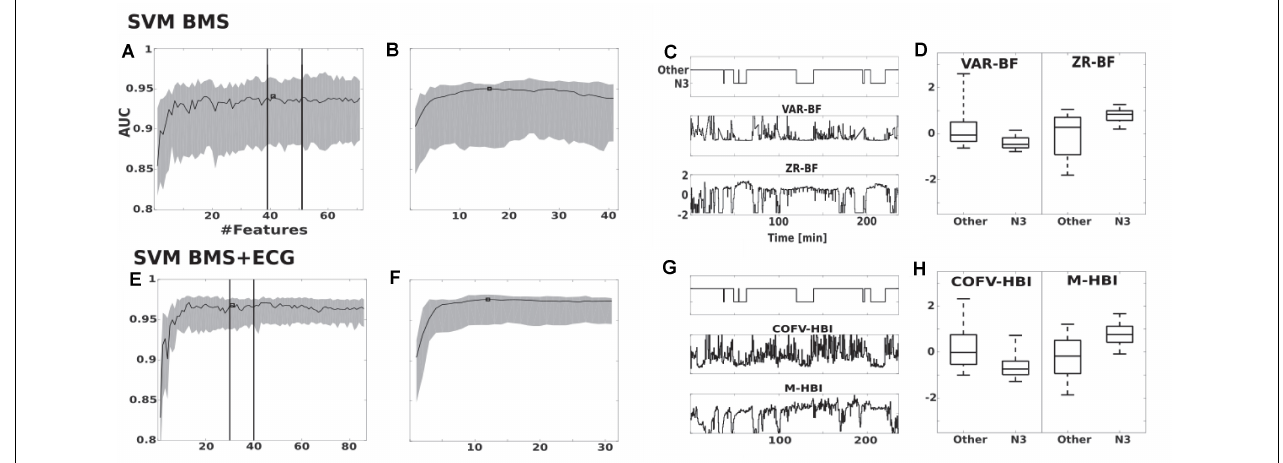
FIGURE 2 | Feature selection of SVM BMS and SVM BMS + ECG classifiers. (A,B) The effect on AUC of adding features in the SVM BMS. The traces show the median and interquartile range of AUC in the two-step maximum-relevance-minimum-redundancy criteria feature selection (A) filter and (B) wrapper phase. Vertical lines indicate the consistent performance interval and square shows the selected feature set. (C,D) Examples of the two most important features, as a function of PSG study as well as comparison of all epochs. (E–H) Corresponding results for SVM BMS + ECG classifier. VAR-BF, variance in 6–16 Hz bed mattress signal band (BF), was the first selected feature for both SVM BMS and SVM BMS + ECG classifiers. The second selected feature was ZR-BF, the number of zero crossing of twice differentiated BF band, and COVF-HBI, the coefficient of variation of heart beat intervals (HBI), for SVM BMS and SVM BMS + ECG, respectively. The third selected feature was M-HBI, the mean of HBI for SVM BMS + ECG.